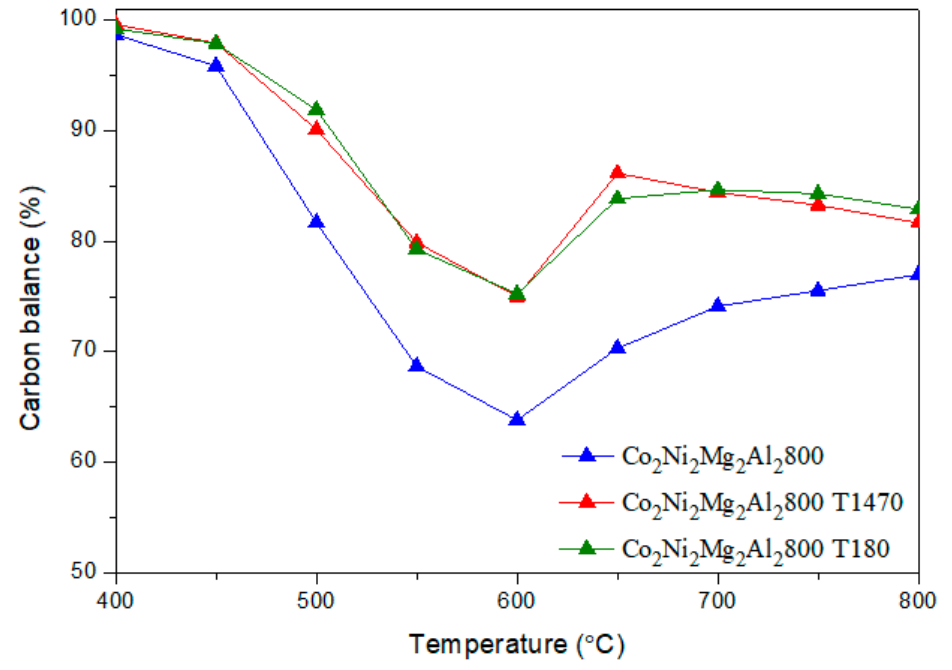
Figure 11. Carbon balance in DRM versus reaction temperature on the catalyst Co 2 Ni 2 Mg 2 Al2800 with and without